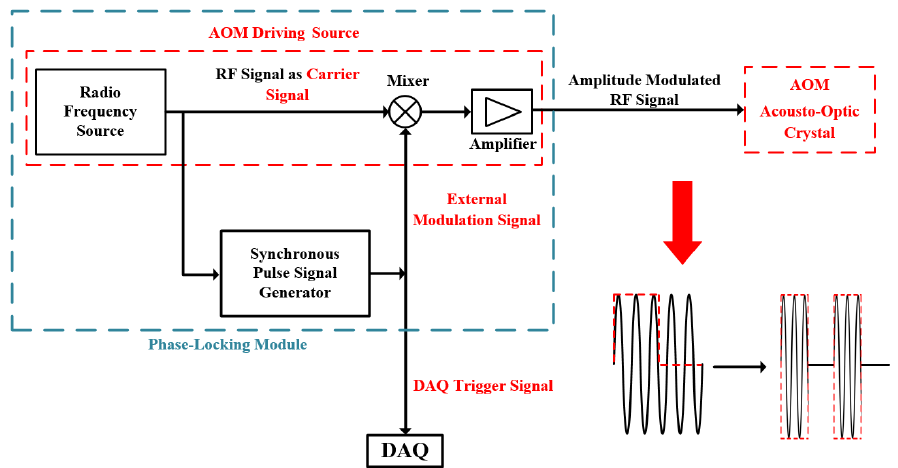
Figure 4. Scheme of the phase-locking module for providing a clock homologous carrier signal, modulation signal and DAQ trigger signal.